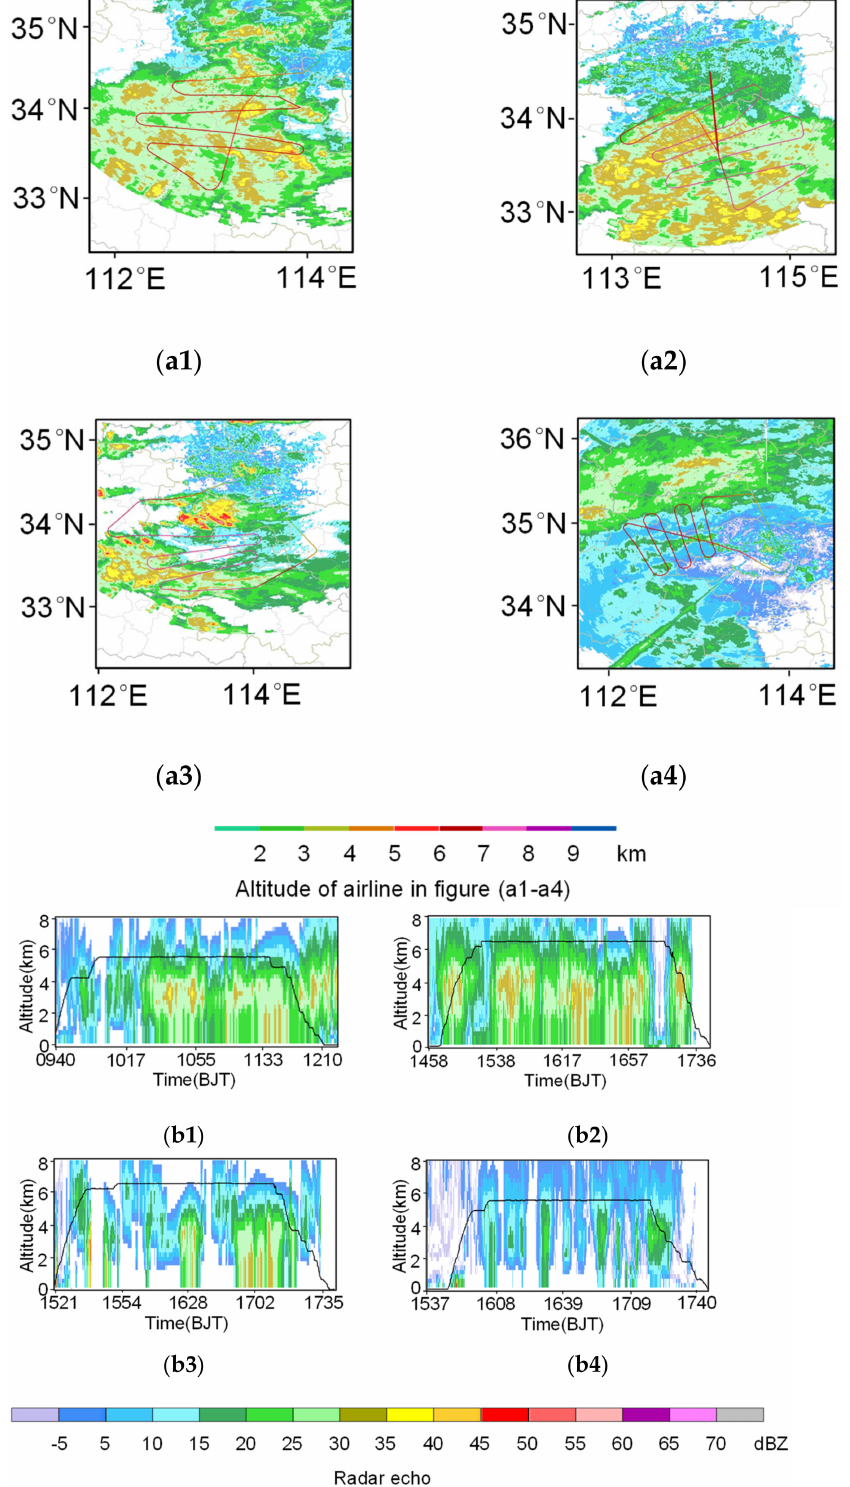
Figure 2. Overlay of the airline and radar echo plane ( a1 – a4 ), vertical radar profile ( b1 – b4 ) of No.1–4 aircraft precipitation enhancement